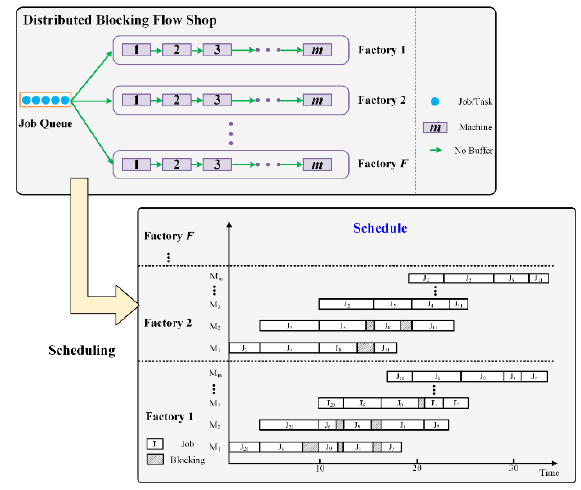
Figure 1. An example of DBFSP with the Gantt chart.